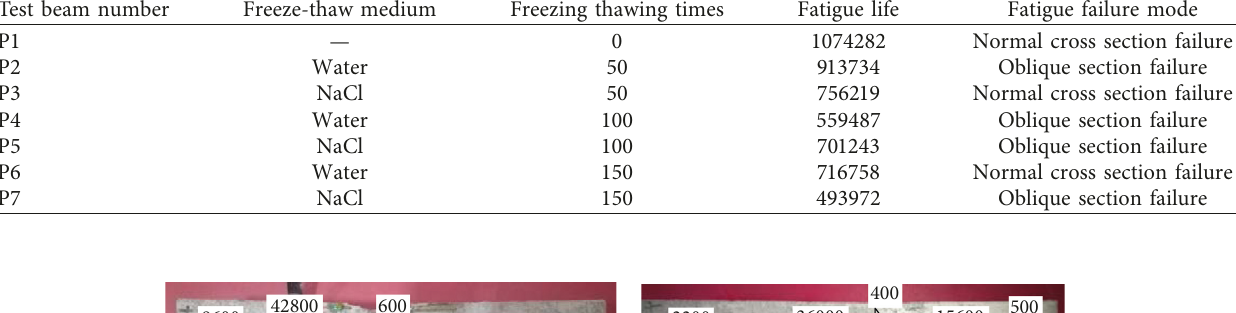
Table 6: Fatigue life of test beams.